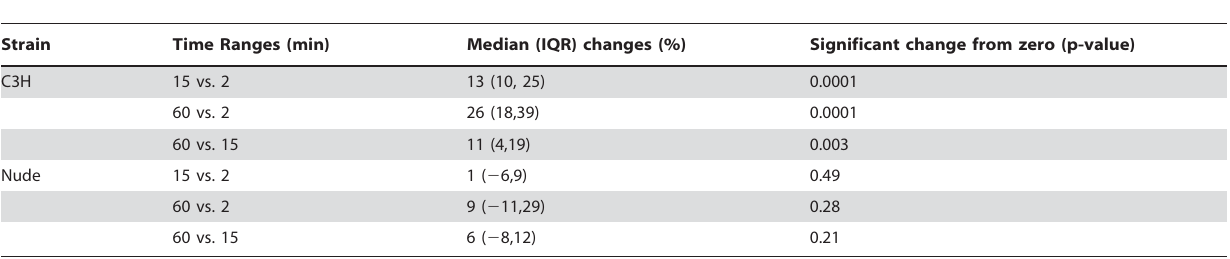
Baseline level of rBF increases in C3H animals, but is stable in nudes.